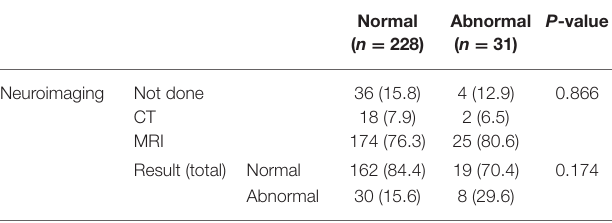
TABLE 4 | Comparison of neuroimaging findings between patients with normal and abnormal electroencephalograms (EEG).